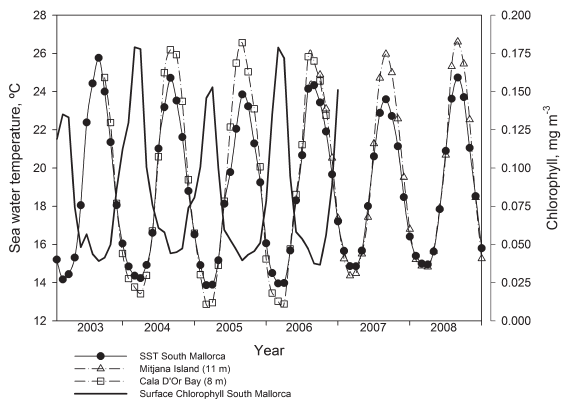
Fig . 1. – Monthly average surface sea water temperature (SST, 2003 to 2008) and chlorophyll concentration at the sea surface (2003 to 2006) in the south of Mallorca (western Mediterranean) calculated from satellite images. The monthly average of seawater temperature recorded at two shallow locations on the south coast of Mallorca (squares: Cala D’Or Bay, 9/2003 to 10/2006; triangles: Mitjana Island, 9/2006 to 12/2008) is also